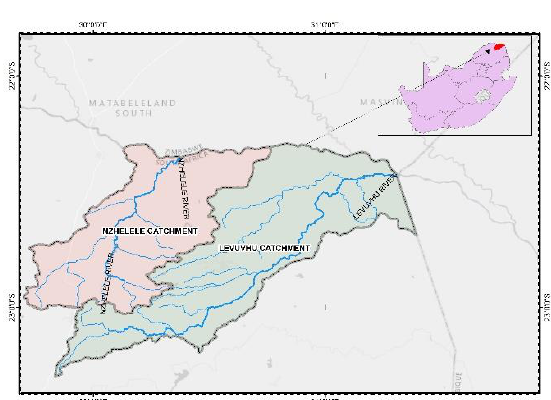
Figure 1: Map showing the location of the study